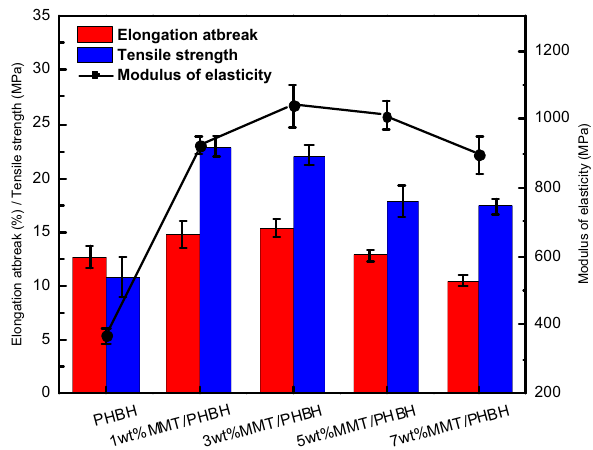
Figure 6: Tensile strength, elongation at break, and elastic modulus of MMT/PHBH biocomposites.